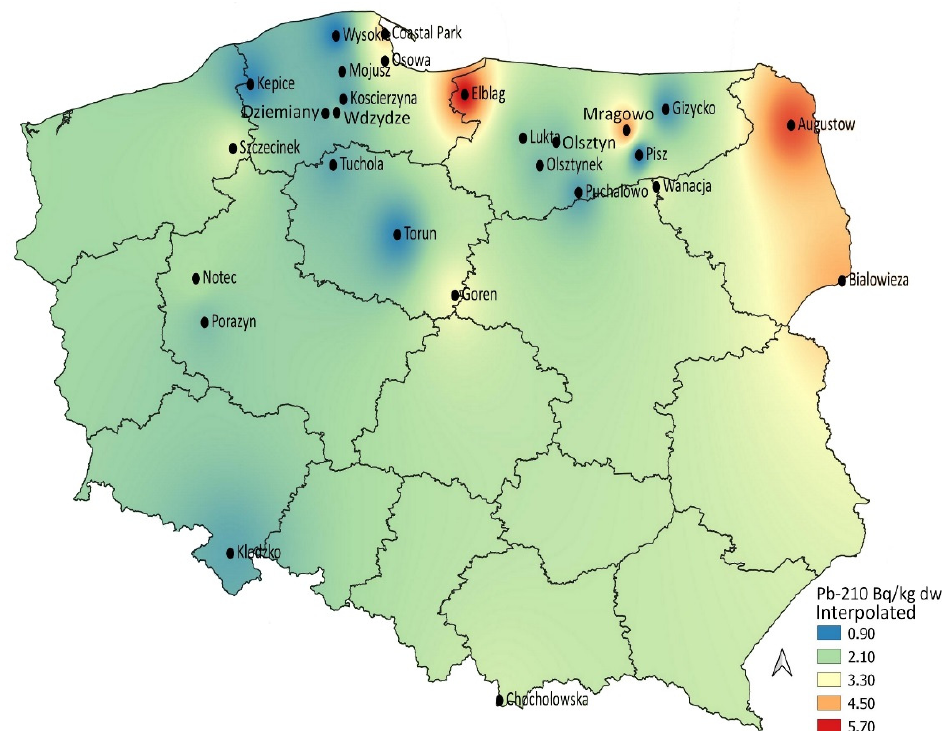
Figure 2. Interpolation map of 210 Pb activity concentrations in boletes.